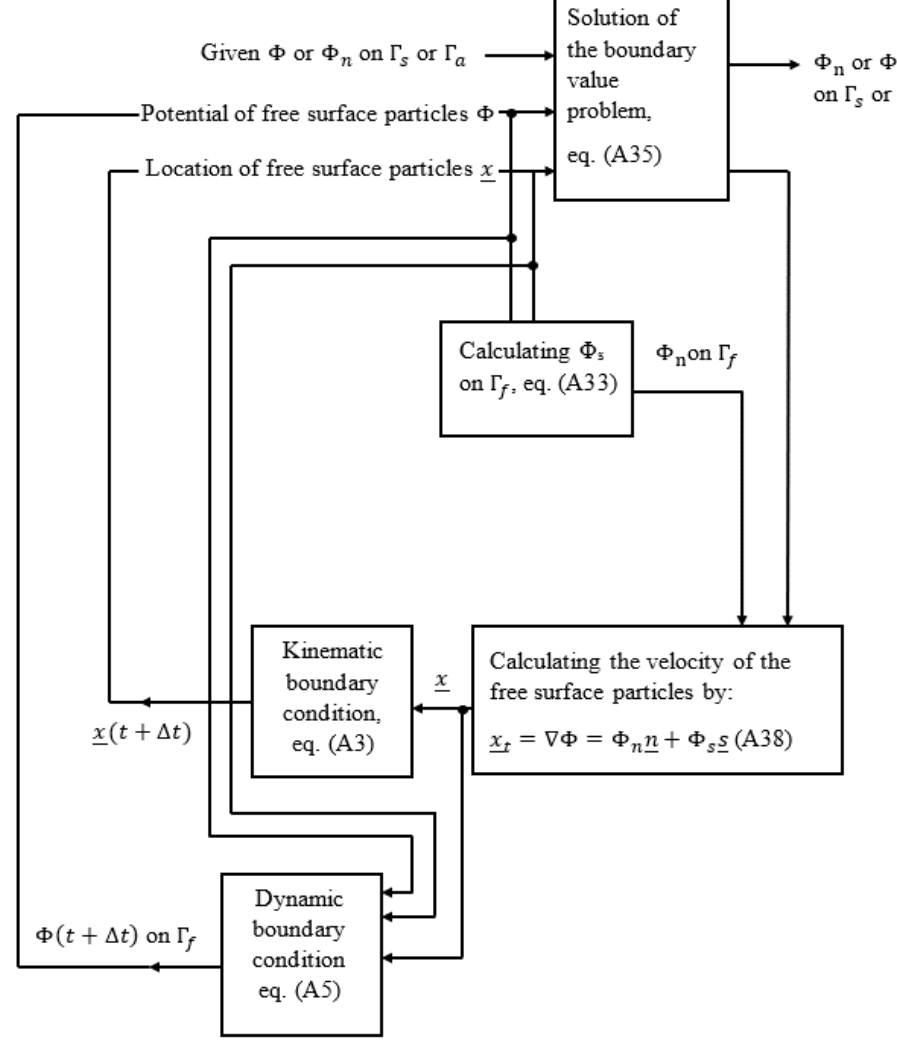
Figure A4. A flowchart of the solution procedure.